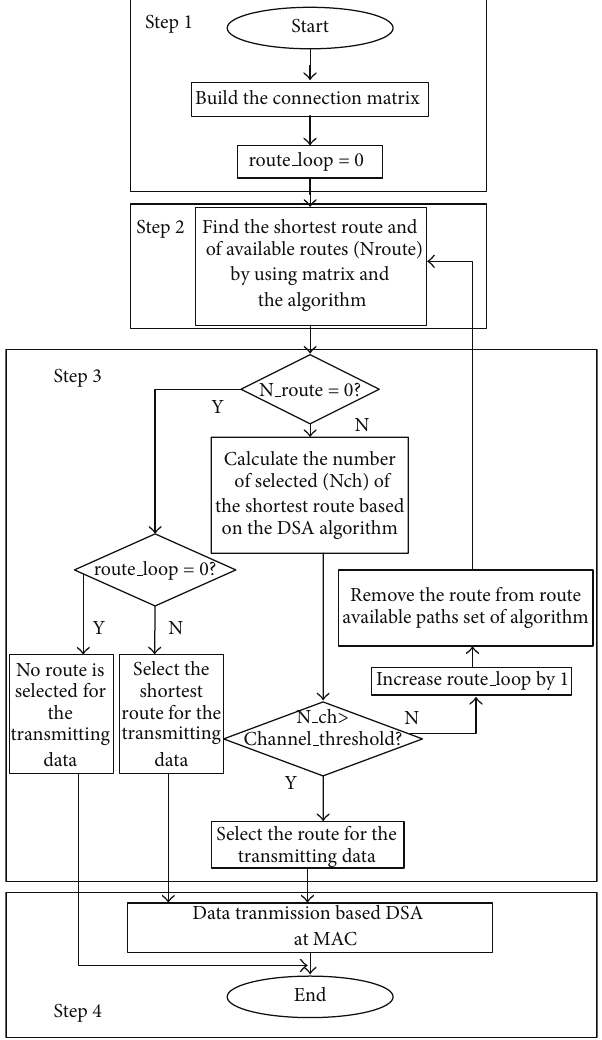
Figure 4: Flowchart of the proposed routing protocol.